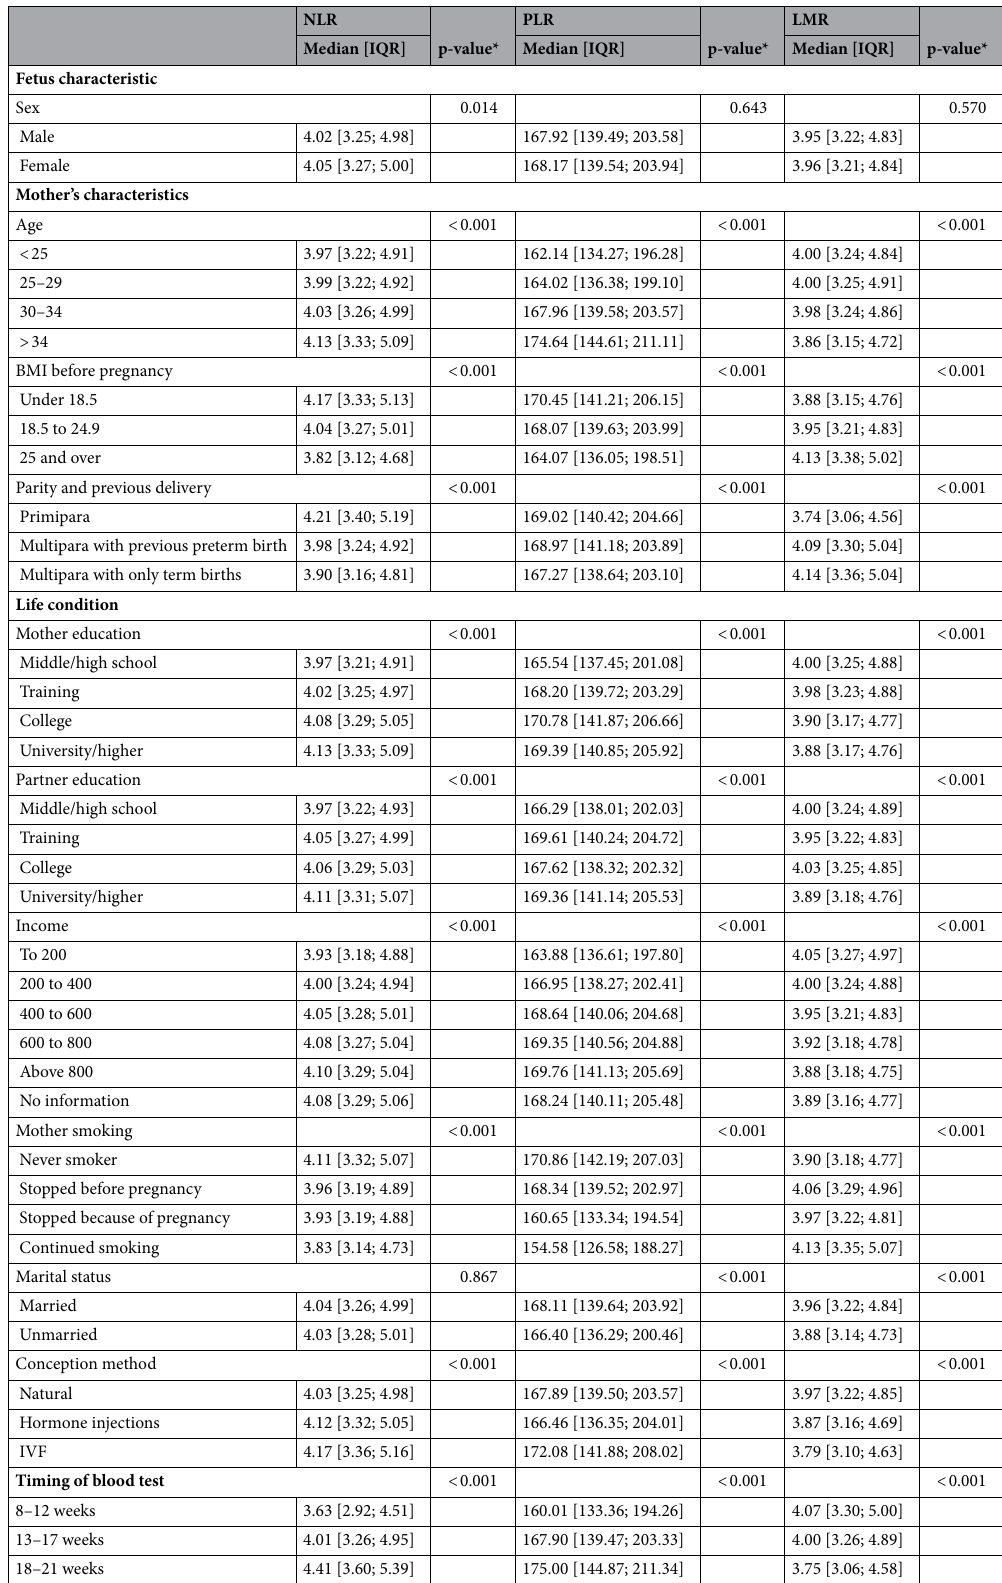
Table 1. Blood count parameter values by maternal characteristics. *Kruskal–Wallis